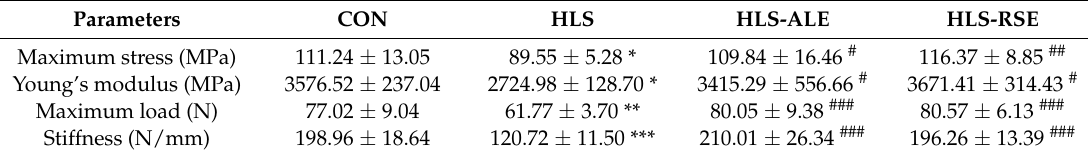
Table 1. Effect of RSE treatment on bone biomechanical parameters in rat femoral diaphysis for male and female rats.